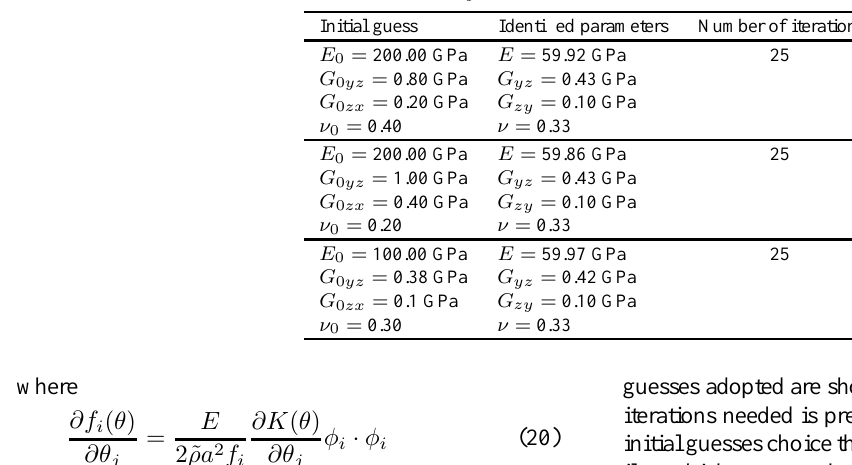
Table 1 Computed E,G yz ,G zx and ν for three different initial